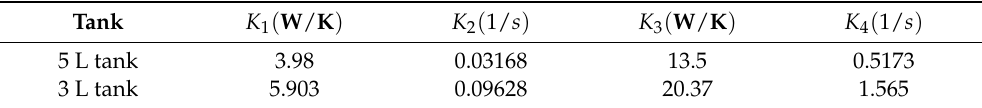
Table 1. Identification parameters of overall heat